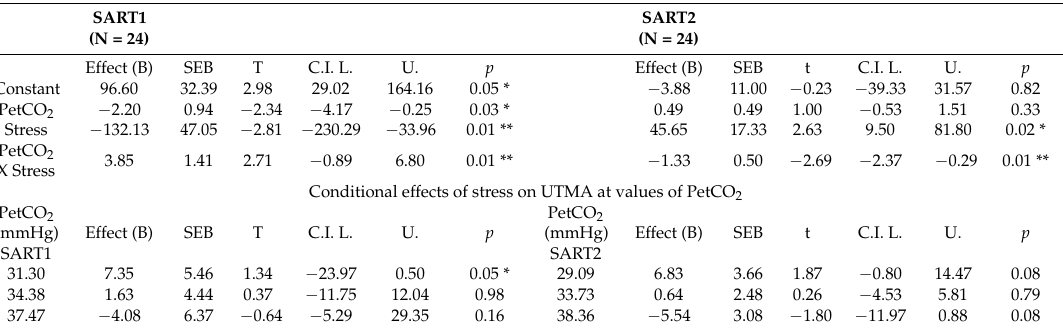
Table 3. Moderation model results for SART1 and SART2.